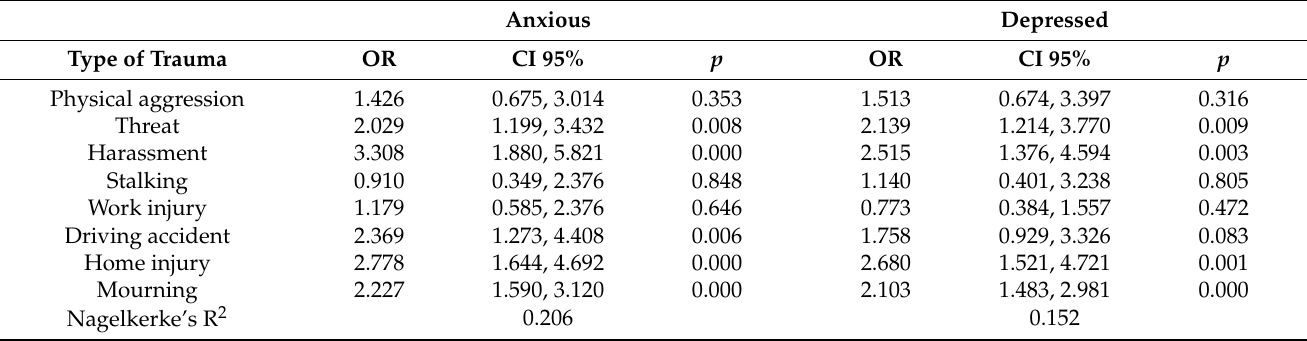
Table 4. Association of traumatic events with cases of anxiety and depression. Logistic regression models adjusted for age and